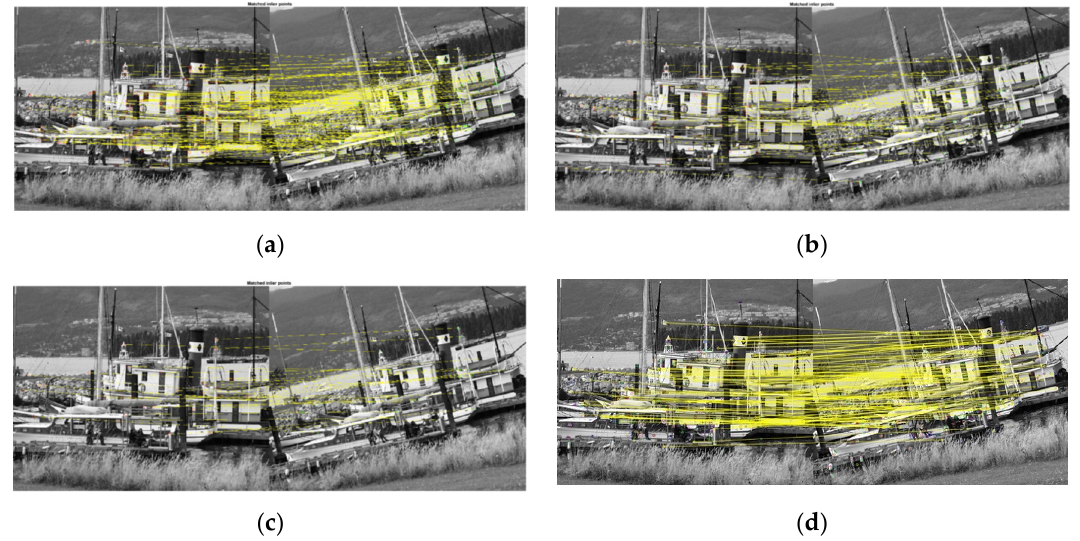
Figure 9. Matching results between image 1 and image 2 in the Oxford boat sequence ( a ) rSYBA; ( b ) Speeded-Up Robust Features (SURF); ( c ) Binary Robust Invariant Scalable Key-points (BRISK); ( d ) Oriented Fast and Rotated BRIEF (ORB). Table 3. Metrics Boat Image Sequence between Images 1 and 2 and Images 1 and 3.